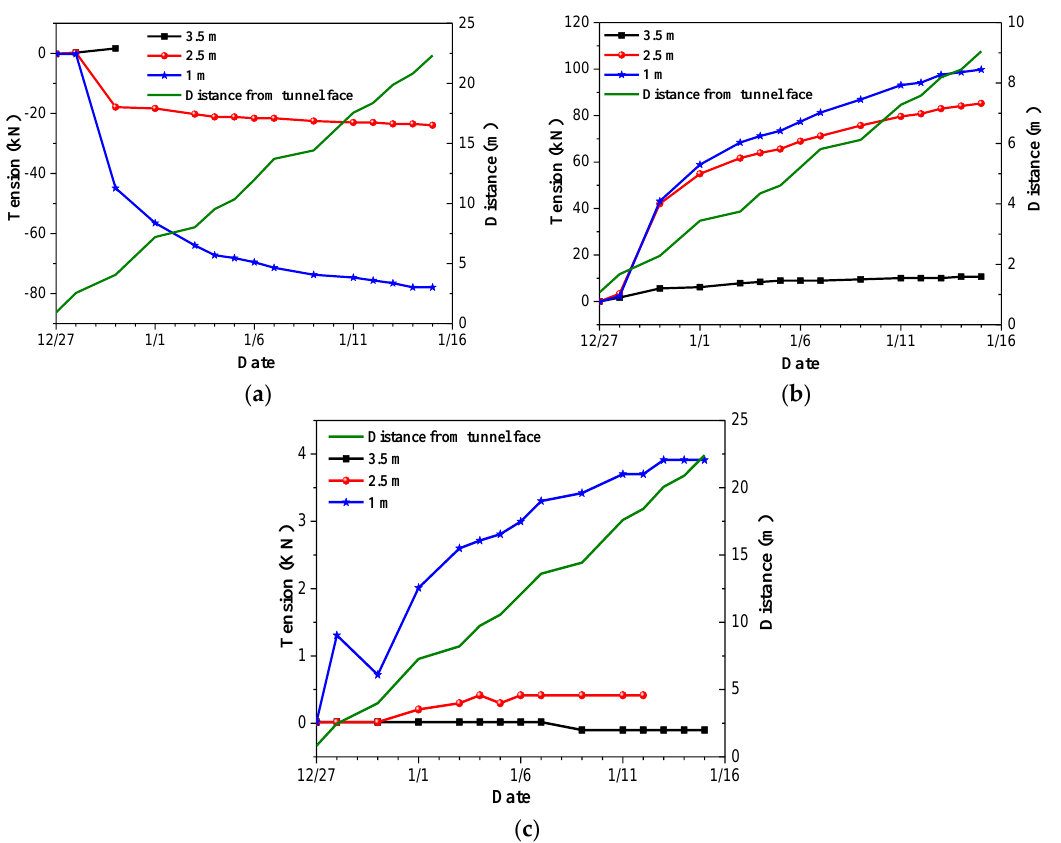
Figure 13. Monitoring results of bolt stress in Section 5: ( a ) right vault shoulder; ( b ) left hance; ( c ) right hance.